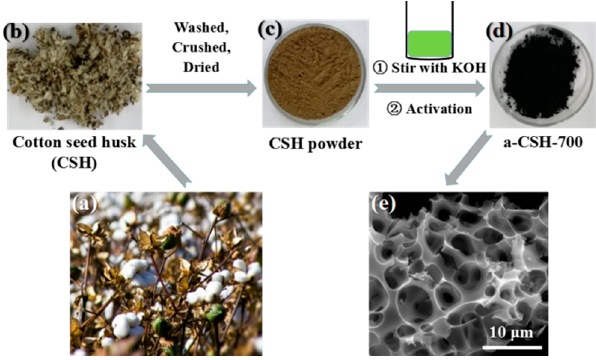
Figure 1. Schematic diagrams for the fabrication of a-CSH-700 and the corresponding scanning electron microscopy (SEM) image. ( a ) Images of cotton. ( b – d ) Schematic of the synthesis of a-CSH-700